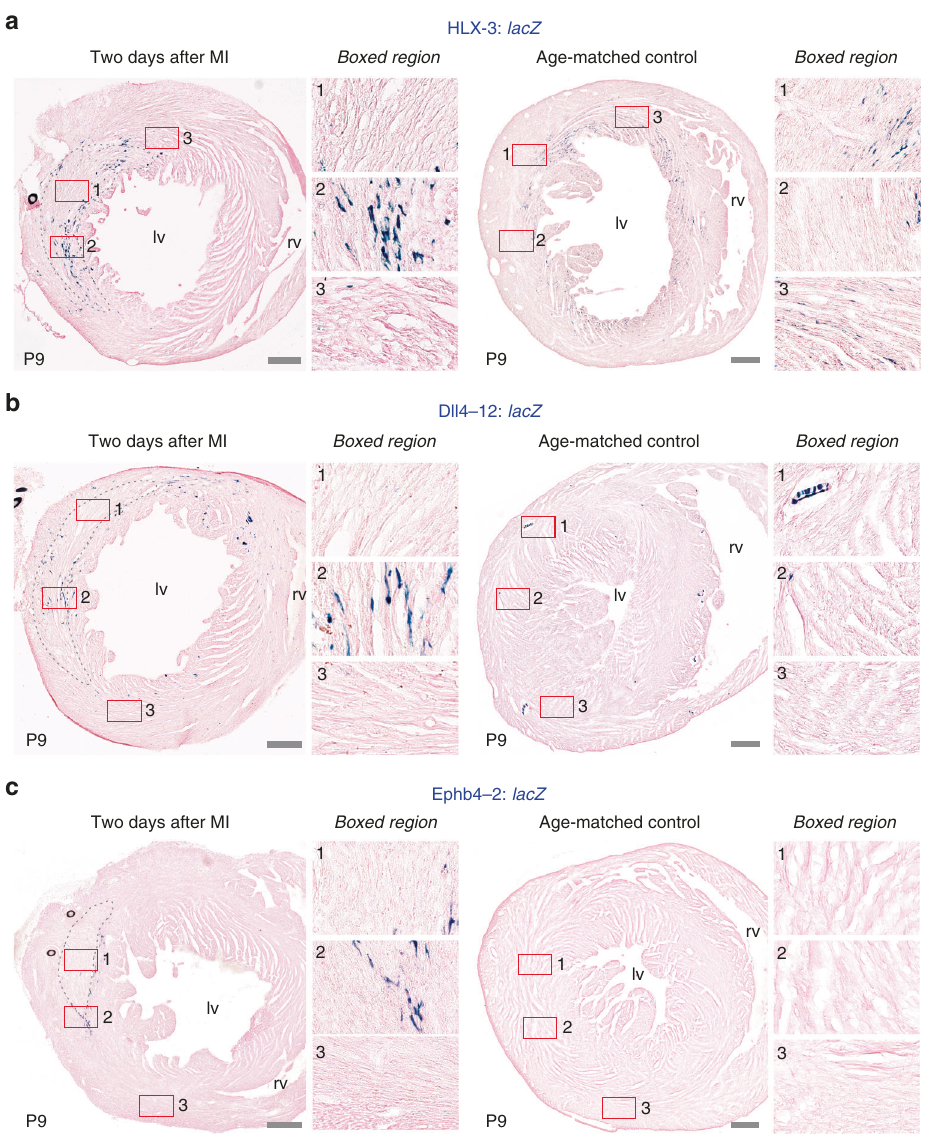
Fig. 9 Developmental vascular regulatory pathways are reactivated during neovascularisation in the less regenerative P7 neonatal heart after MI. a – c Permanent ligation of the left anterior descending coronary artery was performed on transgenic P7 hearts to mimic MI. Representative sections through P9 HLX-3: lacZ ( a , n = 6 biologically independent animals), Dll4-12: lacZ ( b , n = 5 biologically independent animals) and Ephb4-2: lacZ ( c , n = 4 biologically independent animals) transgenic hearts collected two days after MI surgery show robust enhancer activity in ECs surrounding the injured tissue. Dashed grey lines indicate the injured myocardium, and boxed regions show magni fi ed views within the injury (box 1), at the injury border zone (box 2), and at a remote region (box 3). Sections through age-matched control hearts are shown alongside, with comparable boxed regions selected for the magni fi ed views. lv, left ventricle; rv, right ventricle. Grey scale bars represent 200 µ